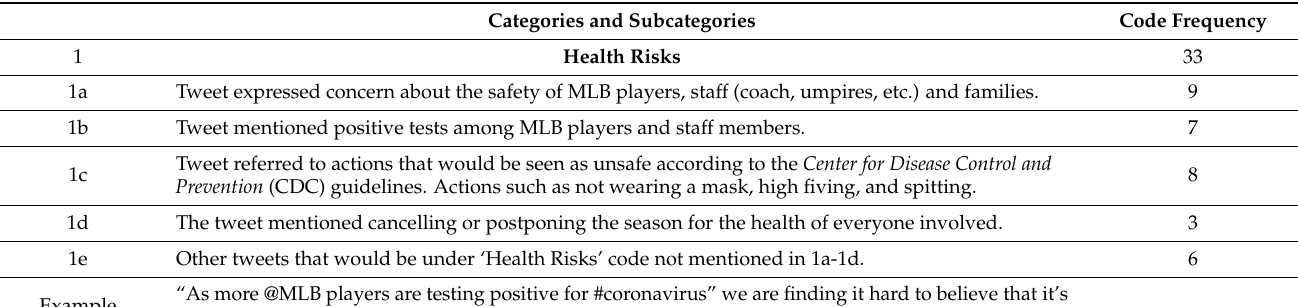
Table 3. Description of codebook categories and